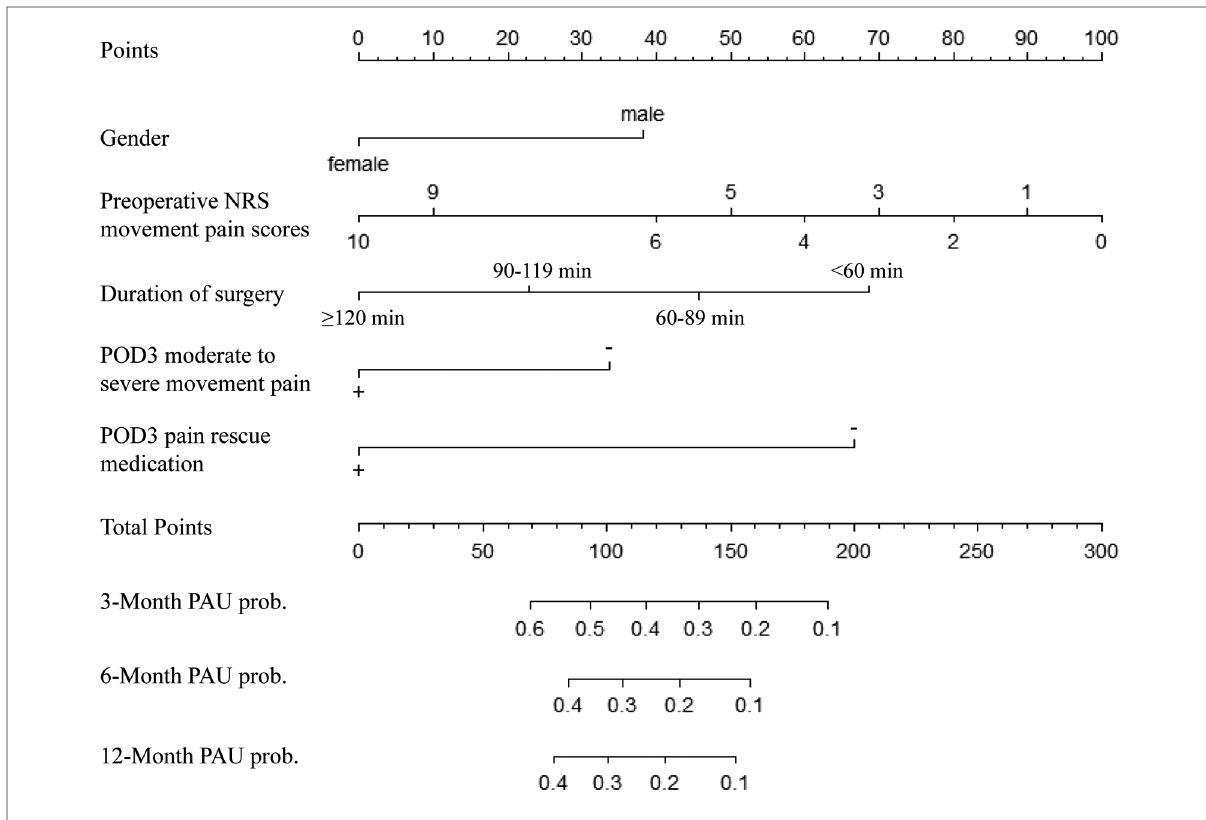
FIGURE 5 Nomogram for predicting